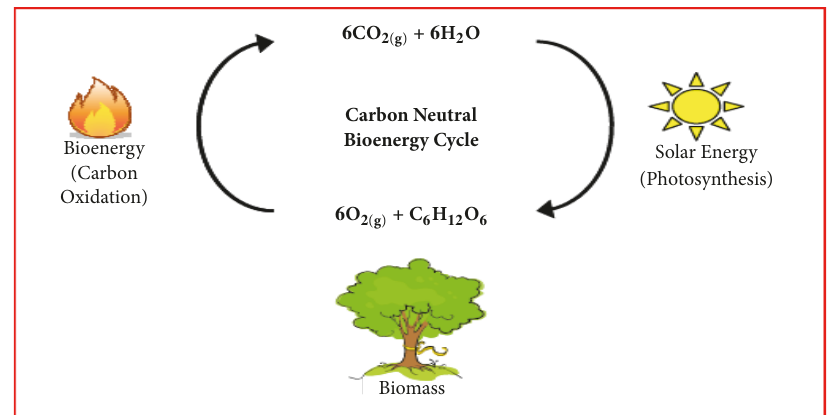
Figure 7: Schematic of balanced carbon